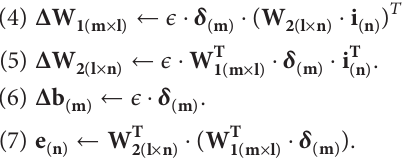
Algorithm 1 illustrates the training process based